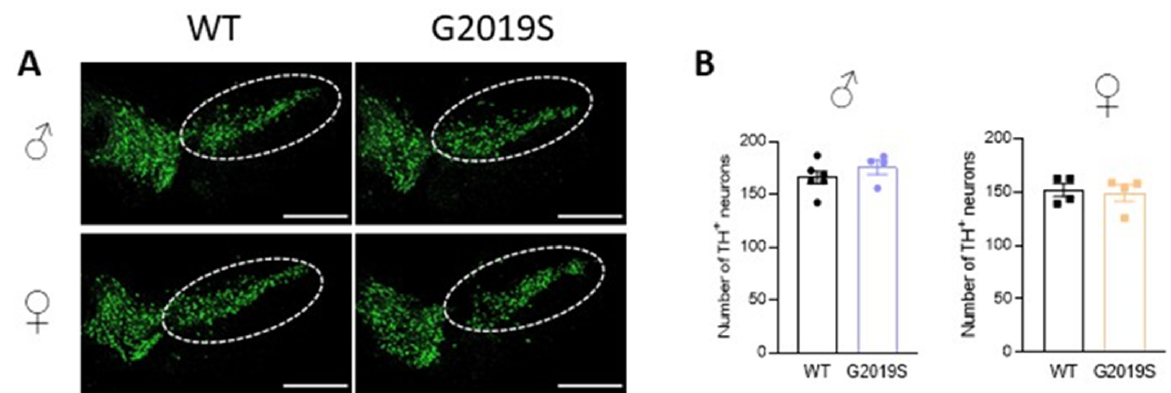
Figure 4. Intact cell counts in the SNc of old WT and G2019S male and female mice. ( A ) Confocal images showing immunofluorescence for TH in midbrain sections containing the SNc (dotted lines) of 20–21 months old WT and G2019S male and female mice; scale bars: 500 µ m. ( B ) Number of TH-positive neurons in the SNc of 20–21 months old mice. N = 6 WT male mice, N = 4 G2019S male mice, N = 4 WT female mice, and N = 4 G2019S female mice.